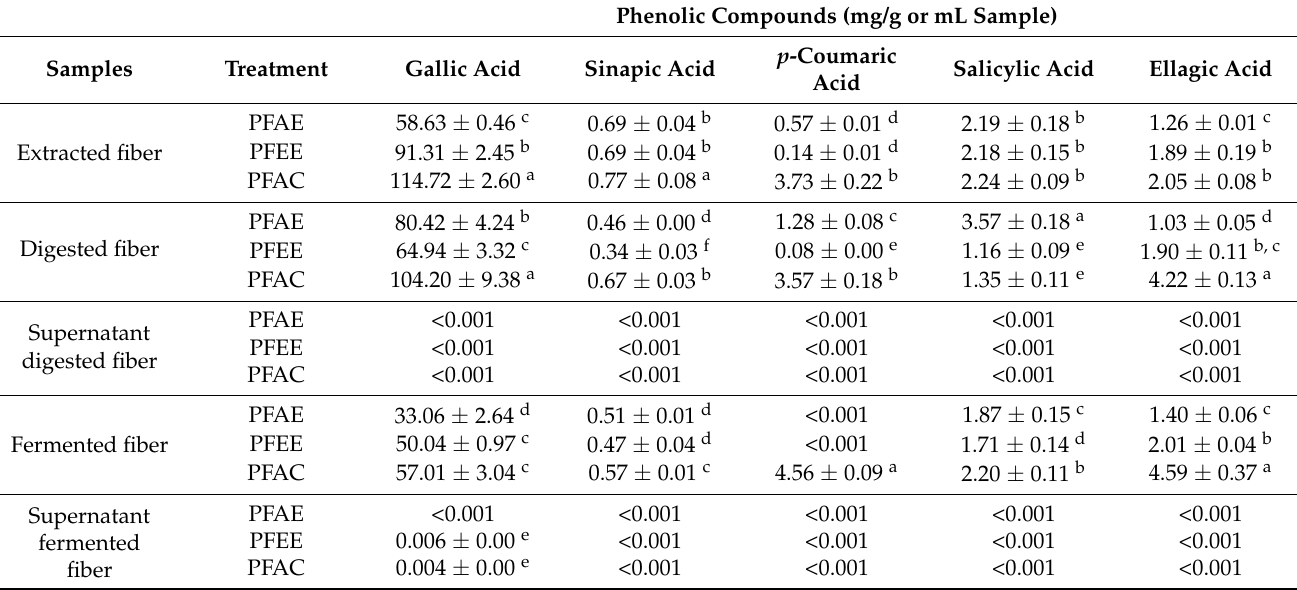
Table 4. Quantification of the most abundant polyphenolic compounds found in treated persimmon fiber fractions.